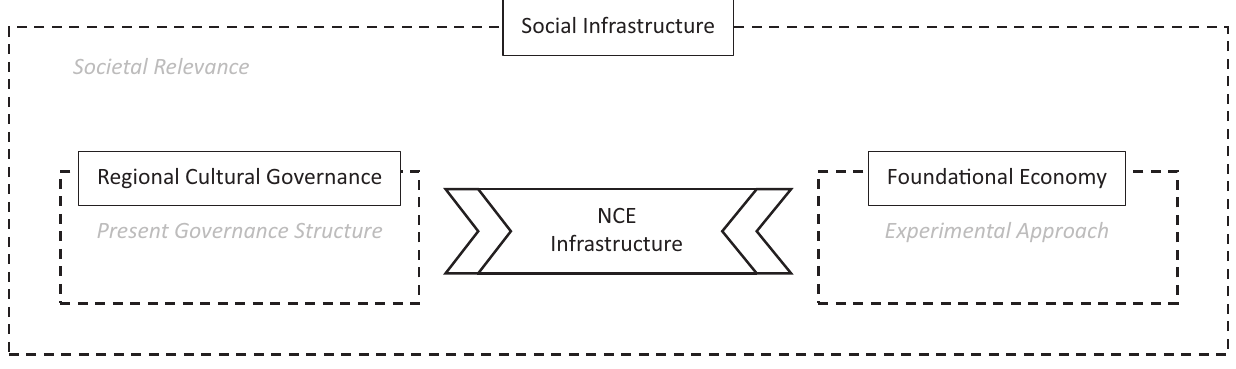
Figure 1. Conceptual